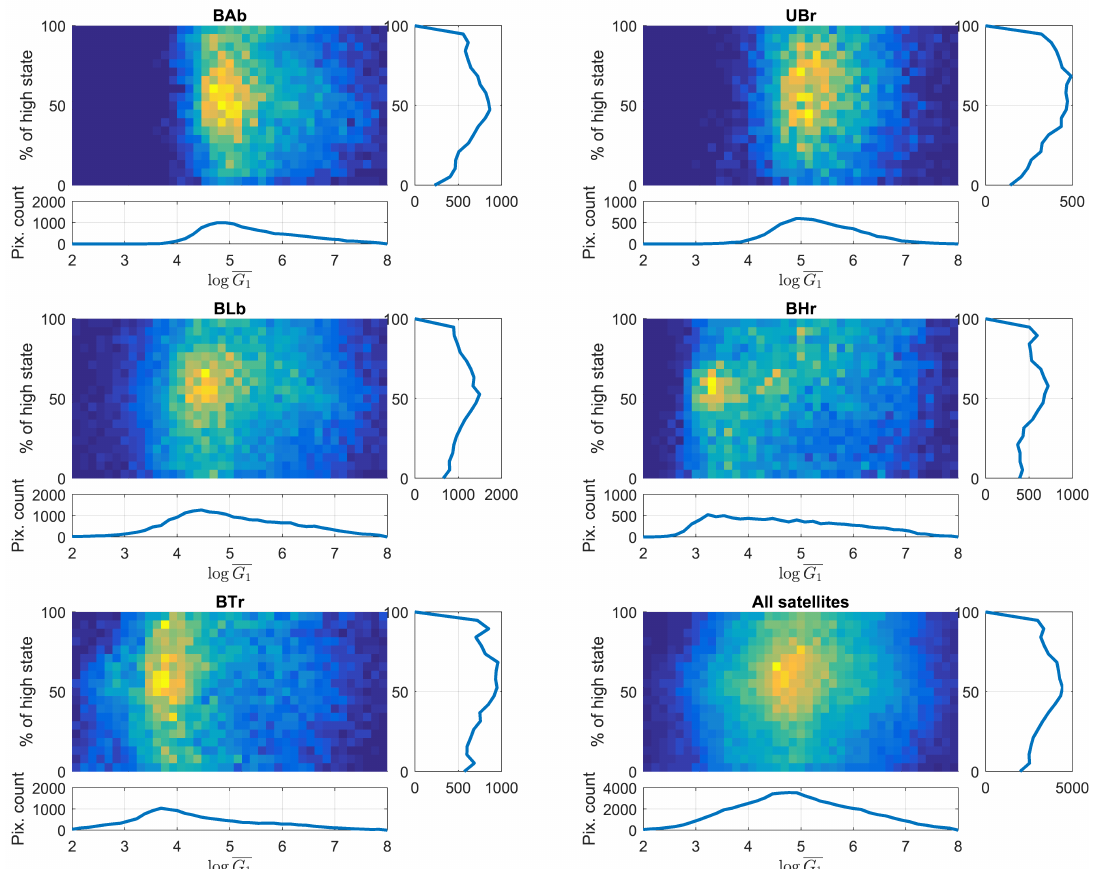
Figure 12. Time distribution between two metastable states in the bistable